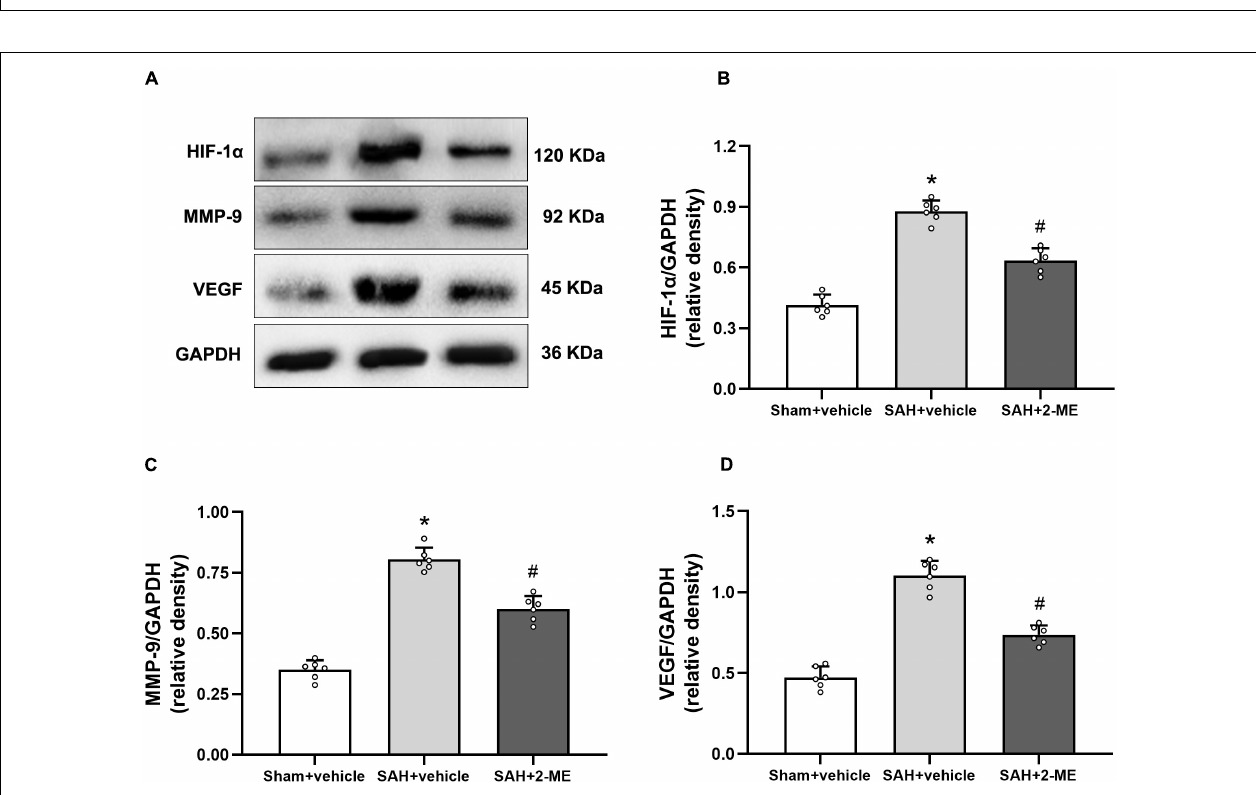
FIGURE 6 | Effect of 2-ME on the expression of HIF-1 α , MMP-9, and VEGF. (A) Representative result of western blotting of HIF-1 α , MMP-9, and VEGF of the ipsilateral basal cortex of in different groups. Western blotting assay for the expression of HIF-1 α (B) , MMP-9 (C) , and VEGF (D) of the ipsilateral basal cortex in different groups at 24 h after SAH induction, respectively. Relative optical densities (O.D.) of HIF-1 α , MMP-9, and VEGF were normalized to that of GAPDH. Data are shown as mean ± SD ( n = 6 per group). * P < 0.05 vs. the Sham + vehicle group; # P < 0.05 vs. the SAH + vehicle group.